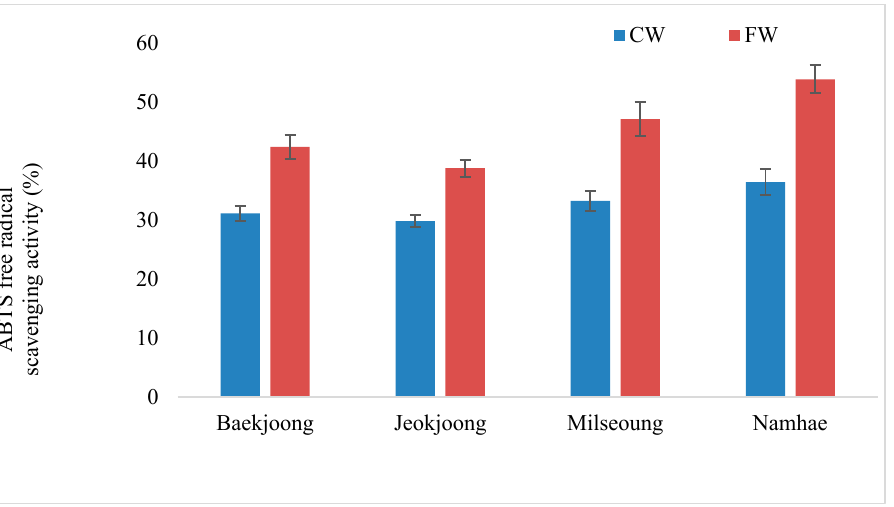
Figure 5. ABTS free radical scavenging activity of cooked wheat and fermented wheat. Error bars (mean ± SD) represent significant differences among the treatments. The data were analyzed with a one-way ANOVA followed by Duncan multiple range tests ( p < 0.05). CW: cooked wheat, FW: fermented wheat.